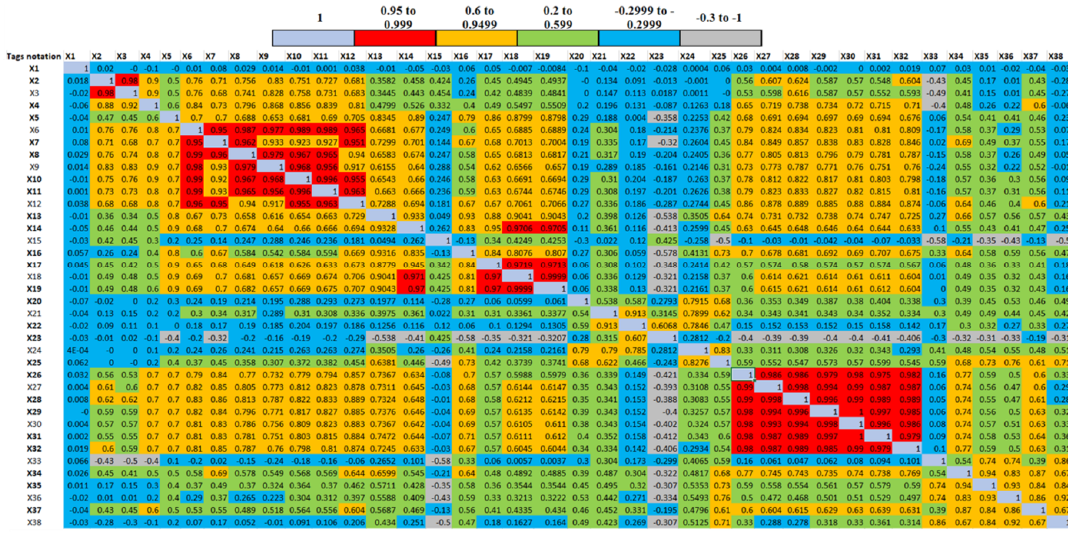
Figure 8. Correlation matrix exhibiting the correlation coefficient between all sensors’ data.